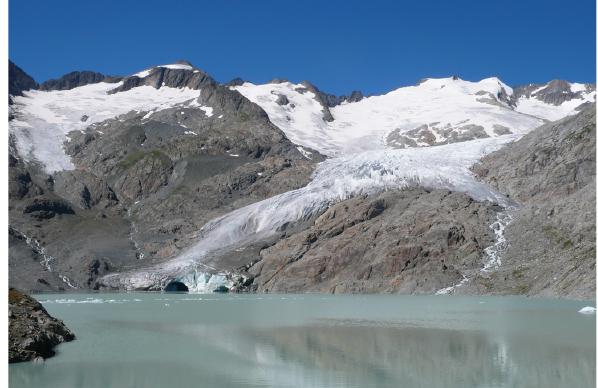
Fig. 1. New lake which recently formed in a pronounced bed overdeepening of Gauli Glacier, Bernese Alps, Switzerland, as a consequence of continued glacier retreat. Another lake is likely to form within the coming years to a few decades in the probably overdeepened bed part indicated by the less inclined glacier sur- face above the bedrock sill with the present steep/thin glacier tongue (cf. Fig. 2 for model simulation/position and Frey et al., 2010, for morphological indications of bed overdeepenings). Photo: Michael B¨utler, 10 August